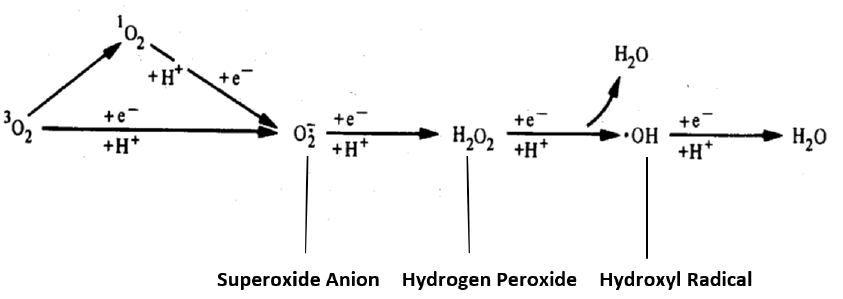
Figure 1. Reductive Pathway of Molecular Oxygen. An important alternate step is shown where an excited state species, singlet oxygen, is produced either via the interaction of molecular oxygen with the excited triplet state of another molecule or an energy exchange reaction upon the absorption of energy from another source, e.g., ultraviolet light [22].